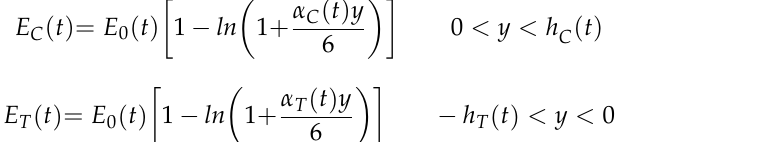
(cid:4666) t (cid:4667) and α (cid:4666) t (cid:4667) were used to describes the dynamic offset of the C T (cid:4666) t (cid:4667) and α (cid:4666) t (cid:4667) , which were uncertain at first, were obtained C T